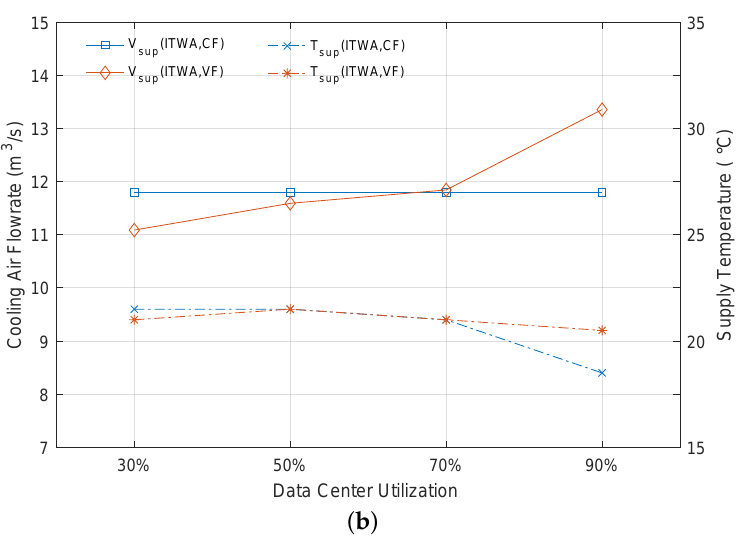
Figure 9. Power consumption and cooling parameters of data center achieved by inlet temperature-aware workload allocation strategy. ( a ) Power consumption under different data center utilization. ( b ) Cooling parameters under different data center